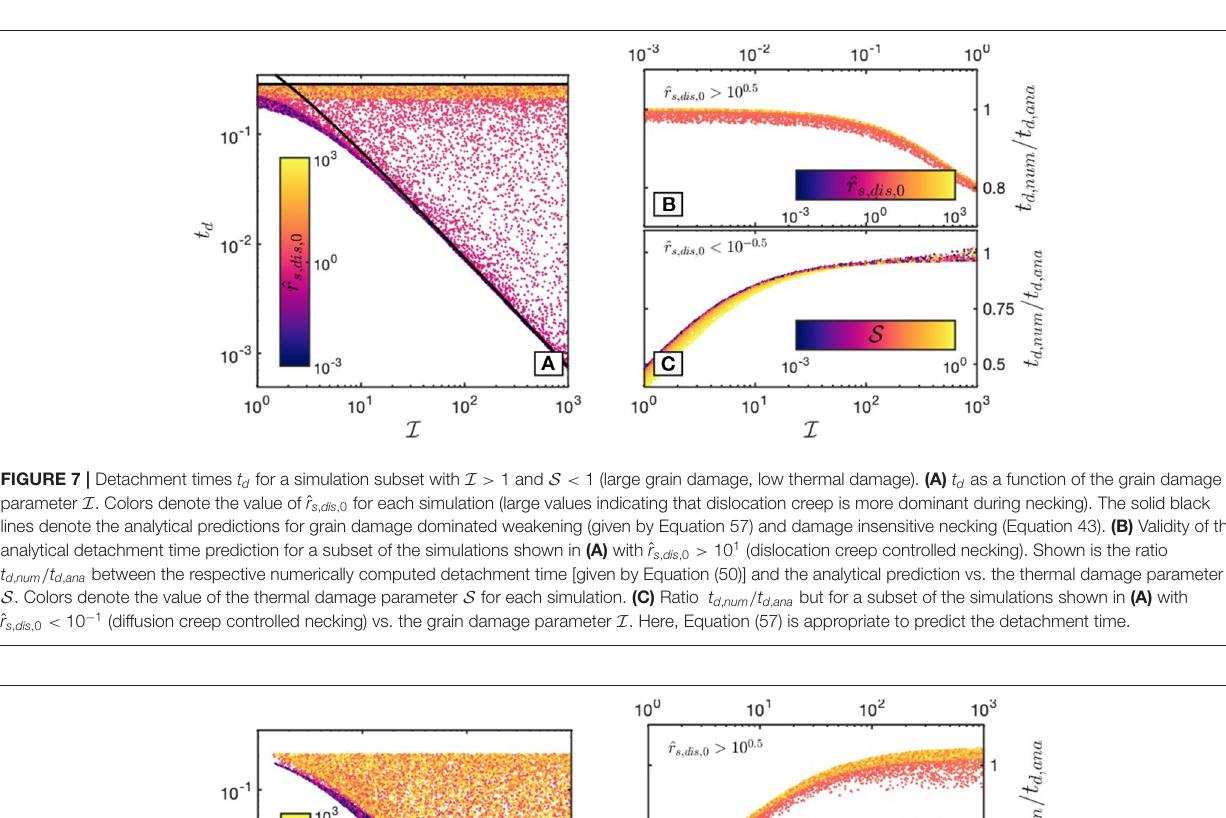
r s , dis ,0 for each simulation (large values indicating that dislocation creep ˆ r s , dis ,0 > 10 0.5 (dislocation ˆ r s , dis ,0 < 10 − 0.5 (diffusion creep controlled necking). Here, Equation (57) is ˆ